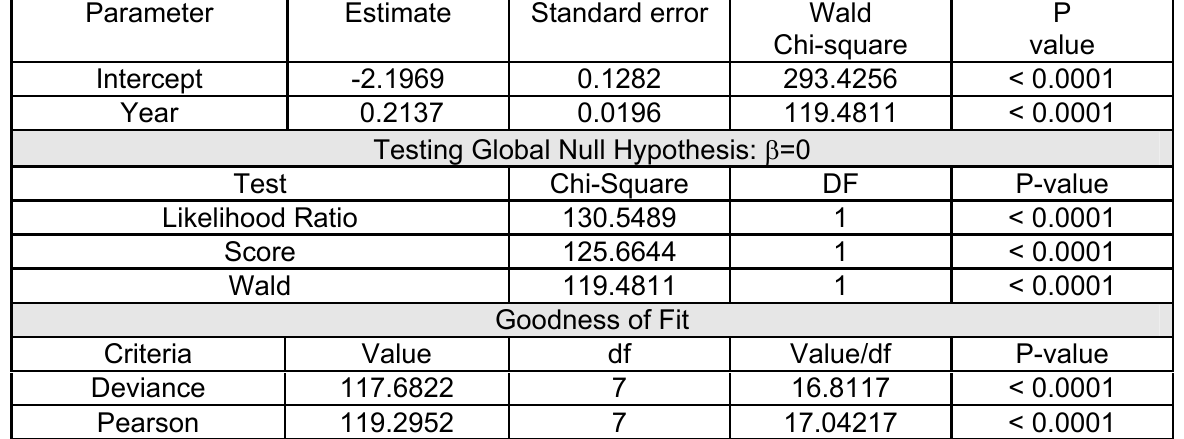
Logistic regression analysis result